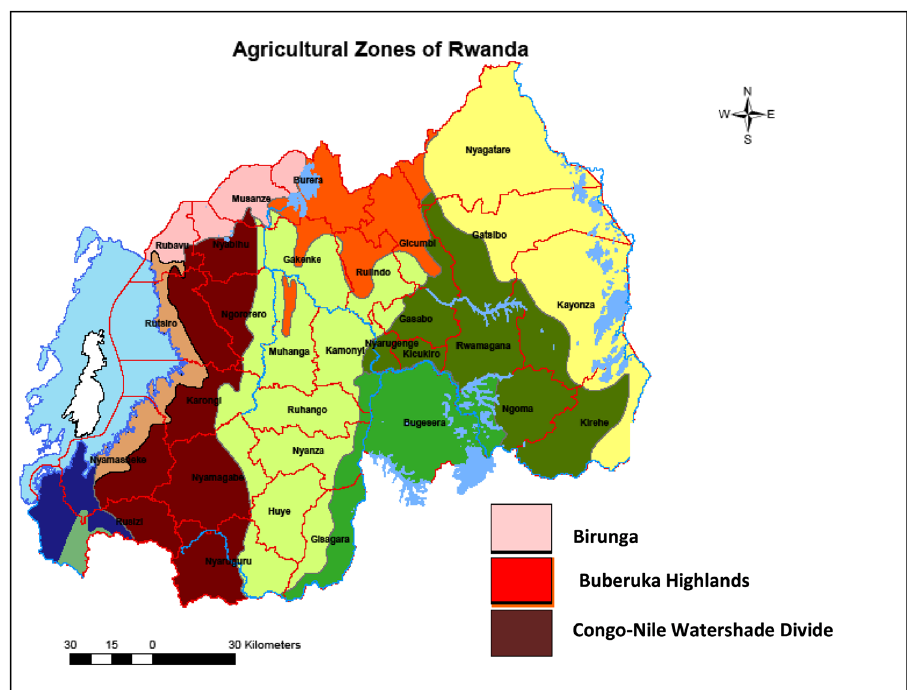
Figure 1: Map of Rwanda with the study